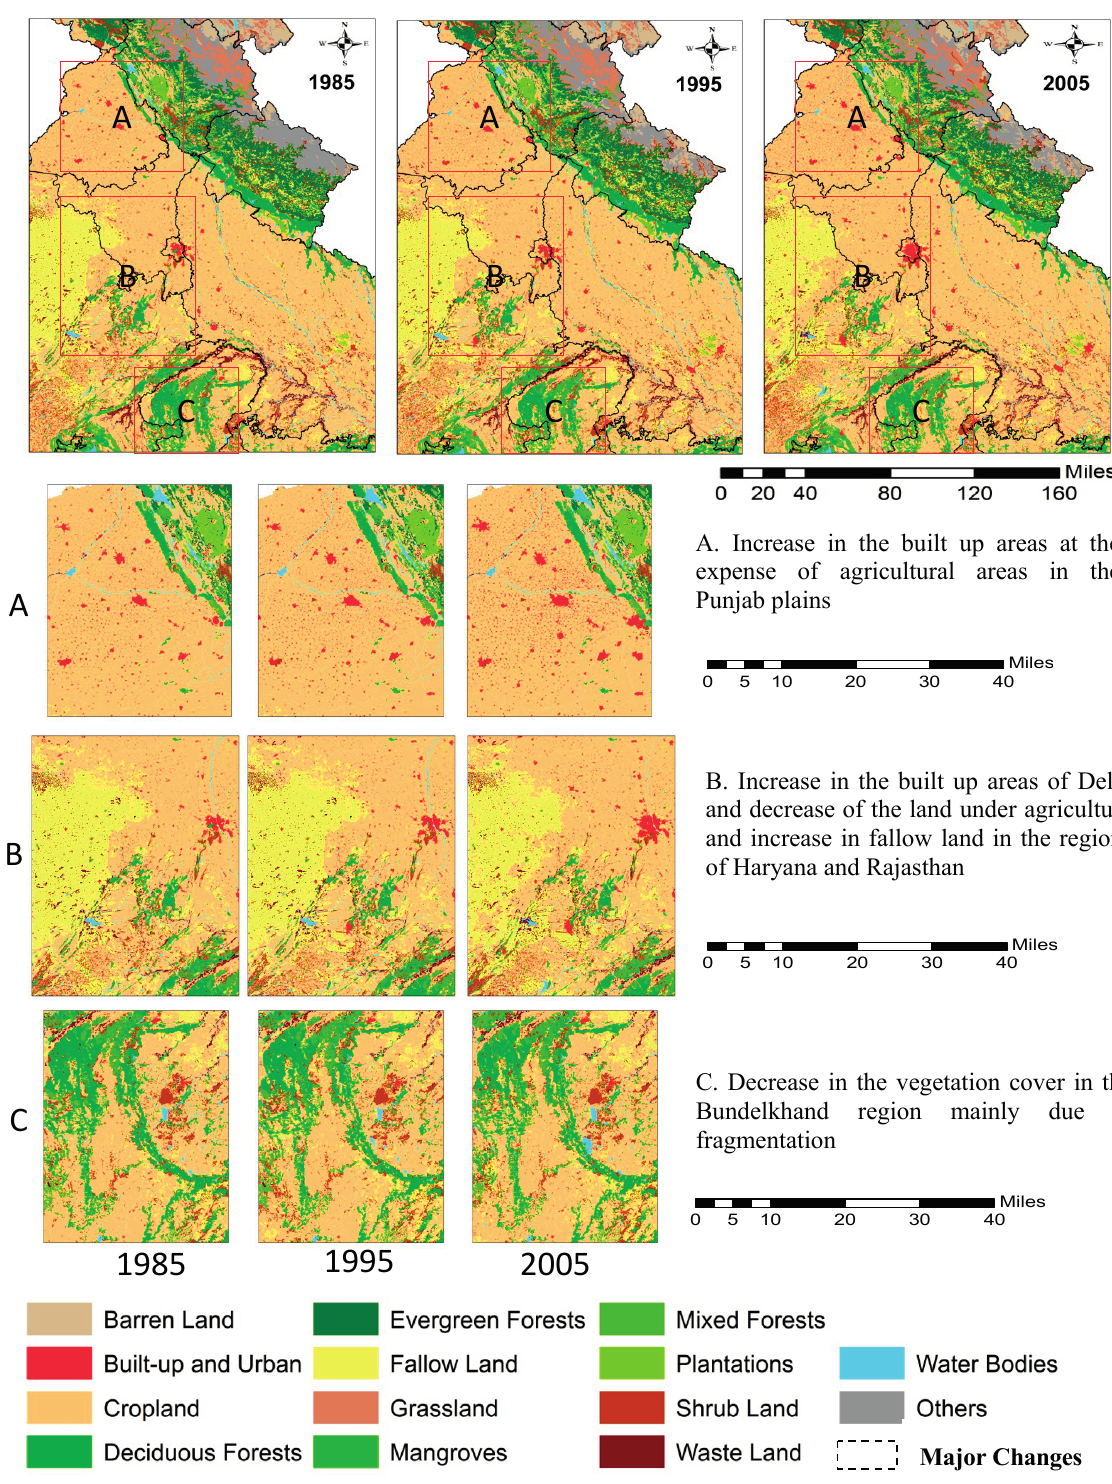
Figure 3. Land-use and land-cover changes in north western India over two decades (1985 – 2005). ( A ). Increase in the built up areas at the expense of agricultural areas in the Punjab plains. ( B ). Increase in the built up areas of Delhi and decrease of the land under agriculture and increase in fallow land in the regions of Haryana and Rajasthan. ( C ). Decrease in the vegetation cover in the Bundelkhand region mainly due to